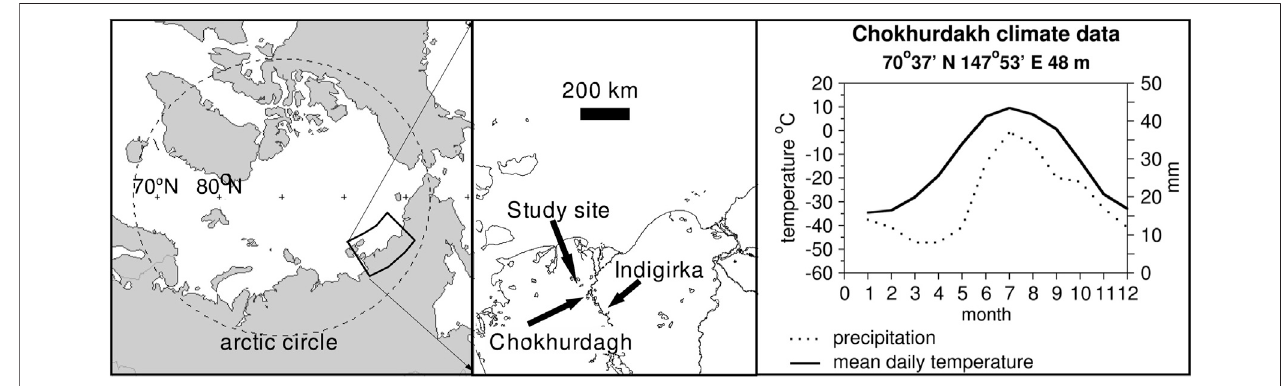
FIGURE 1 | Location of the study area and basic climatology 1970 – 2000